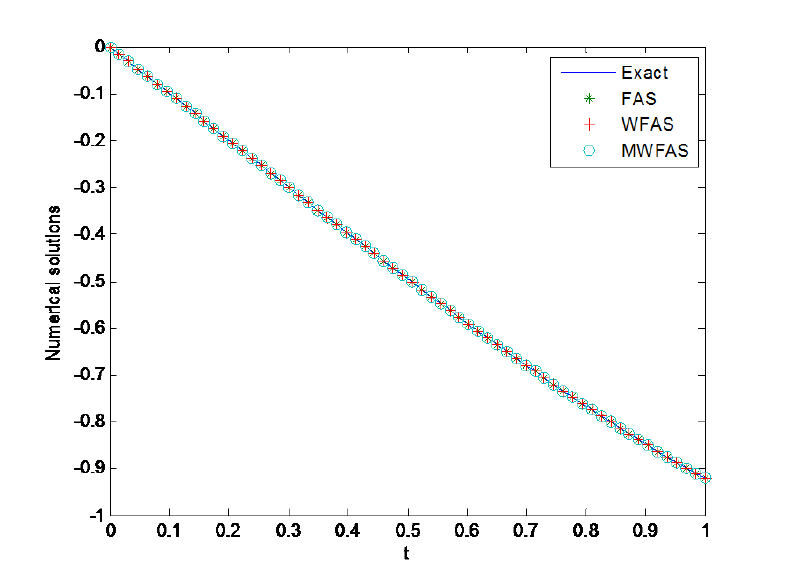
Fig. 5 Comparison of numerical solutions with exact solution of test problem 5.5, for N